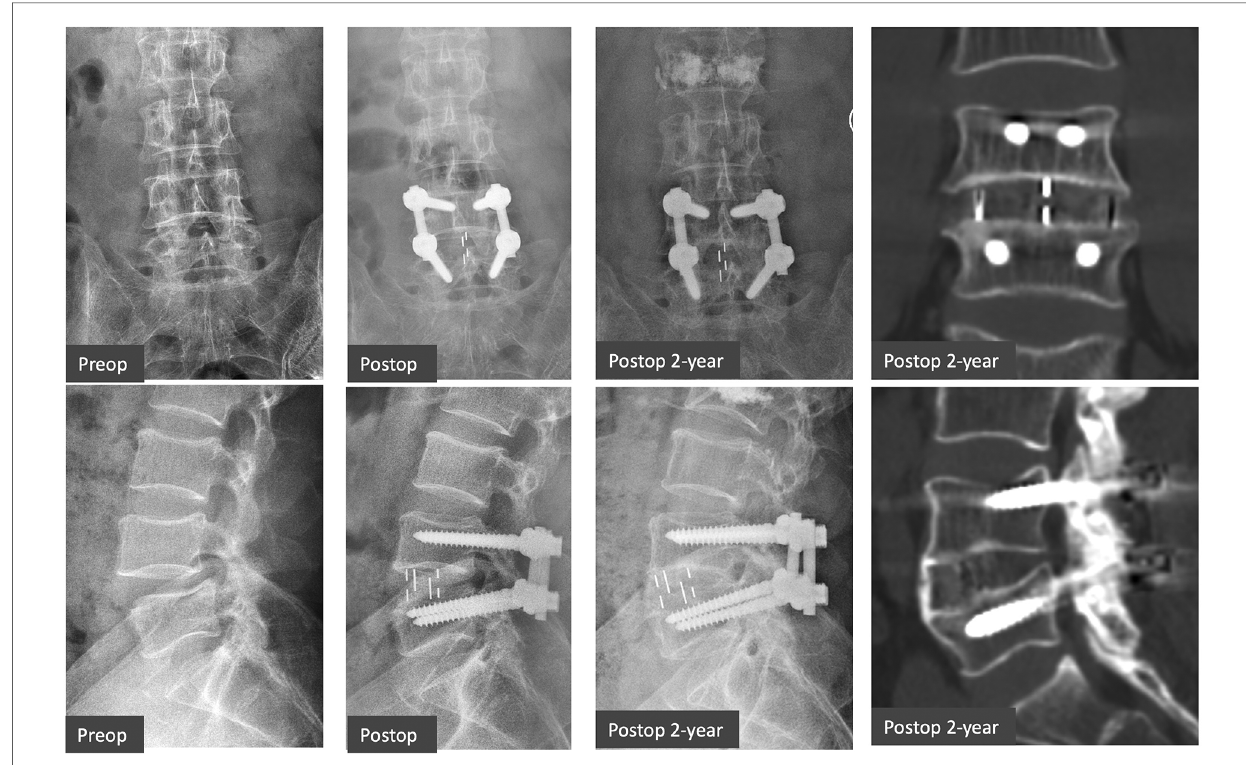
FIGURE 3 Case example of OLIF. A 63-year-old male patient with L4/5 degenerative spondylolisthesis had symptomatic low back pain and radiculopathy (ODI 35.6%, VAS-Leg 6, VAS-Back 6), which were relieved after OLIF with posterior laminotomy and fi xation (ODI 10%, VAS-Leg 1, VAS-Back 2) at 2 years. Grade 1 fusion (apparent bone bridging) on CT scans was achieved at 2 years. OLIF, oblique lumbar interbody fusion; ODI, Oswestry disability index; VAS, visual analog